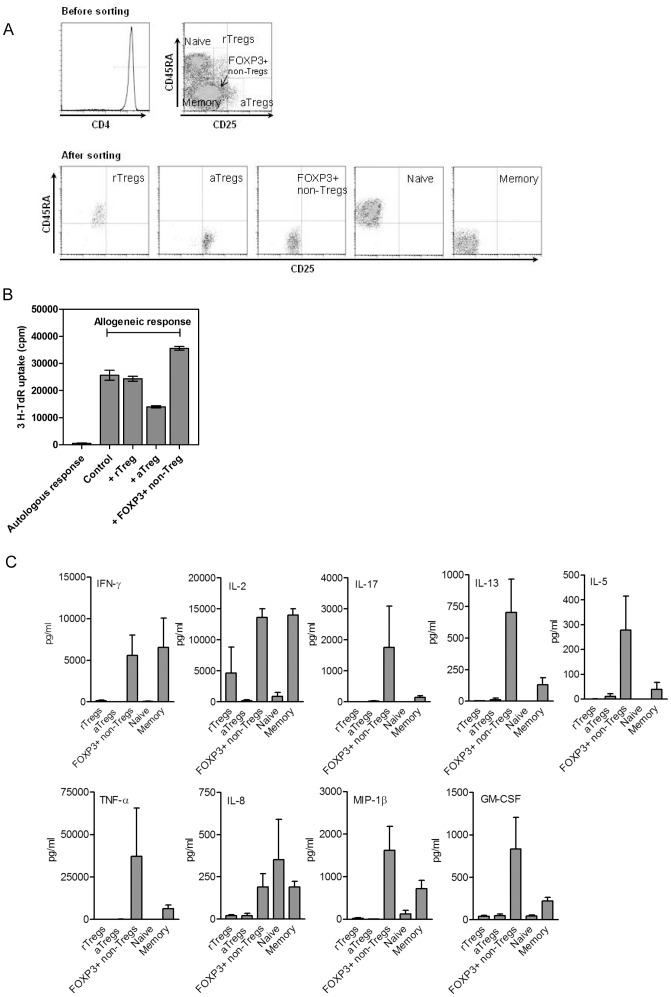
Functional characterization of FOXP3+ T cells in healthy donors.
A. Cell sorting strategy to isolate rTregs, aTregs, FOXP3+ non-Tregs, naive and memory T cells as live cells. Top Panel. A representative histogram showing purified CD4+ T cells isolated from a healthy donor by negative selection. Cells were stained before sorting with anti-CD4, anti-CD25 and anti-CD45RA antibodies. rTreg cells were identified as CD25lowCD45RA+, aTreg cells as CD25highCD45RA-, FOXP3+ non-Tregs as CD25lowCD45RA-, naive T cells as CD25-CD45RA+ and memory T cells as CD25-CD45RA-. Bottom panel. Dot plots of each cellular subset after sorting. The purity of the sorted populations was >98% in all the experiments. The expression of FOXP3 in sorted cells was detected in >90% of aTregs and >80% of either rTregs or FOXP3+ non-Tregs. Only a marginal expression of FOXP3 (<0.5%) was observed in conventional naive and memory T cells. B. The ability of each population of FOXP3+ T cells to suppress the mixed lymphocyte reaction was assessed as described in Materials and Methods. Autologous response or allogeneic responses without the addition of isolated FOXP3+ T cells are included as controls. A representative experiment (n = 3) is shown. C. Determination of the levels of cytokines and chemokines secreted by each activated T cell subset by the Bioplex system. rTregs, aTregs, FOXP3+ non-Tregs, naive and memory T cells were purified from PBMCs by cell sorting. Then, they were stimulated by PMA/ionomycin for 5 h, and the supernatants were harvested. The results are expressed as the mean ± SEM of six independent experiments.